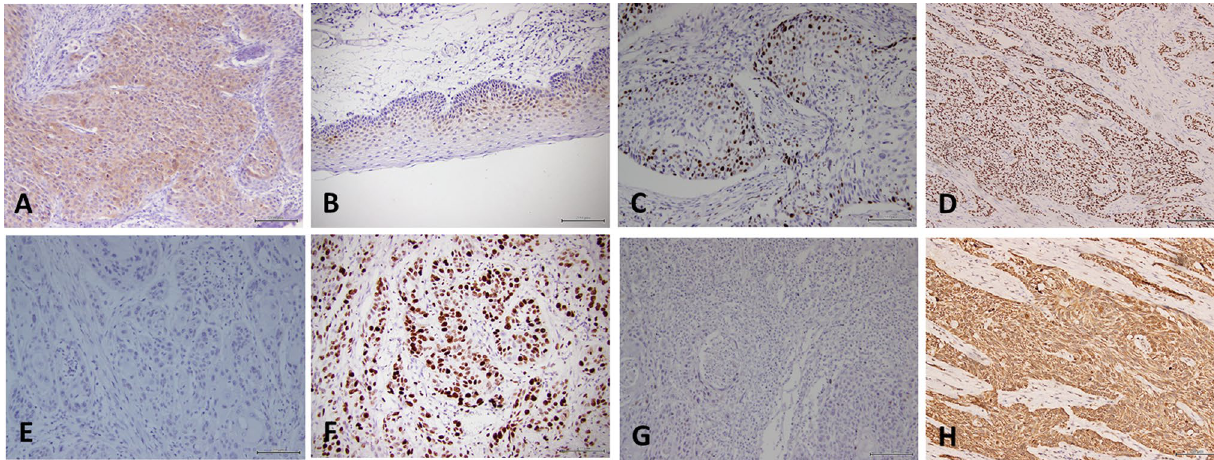
Figure 1. ( A ) Aldosterone reductase family 1 member B10 (AKR1B10) is expressed in the cytoplasm in laryngeal carcinoma tissues, and it is also expressed in individual nuclei. AKR1B10 was diffusely expressed in most laryngeal carcinoma cells. ( B ) AKR1B10 is expressed in the nuclei of cells in squamous epithelial tissue adjacent to the basal layer. ( C ) Low Ki-67 expression in laryngeal squamous cell carcinoma (LSCC). ( D ) High Ki-67 expression in LSCC. ( E ) Negative MTp53 expression in laryngeal carcinoma. ( F ) Positive MTp53 expression in laryngeal carcinoma. ( G ) Negative MMP2 expression in LSCC. ( H ) Positive MMP2 expression in LSCC.